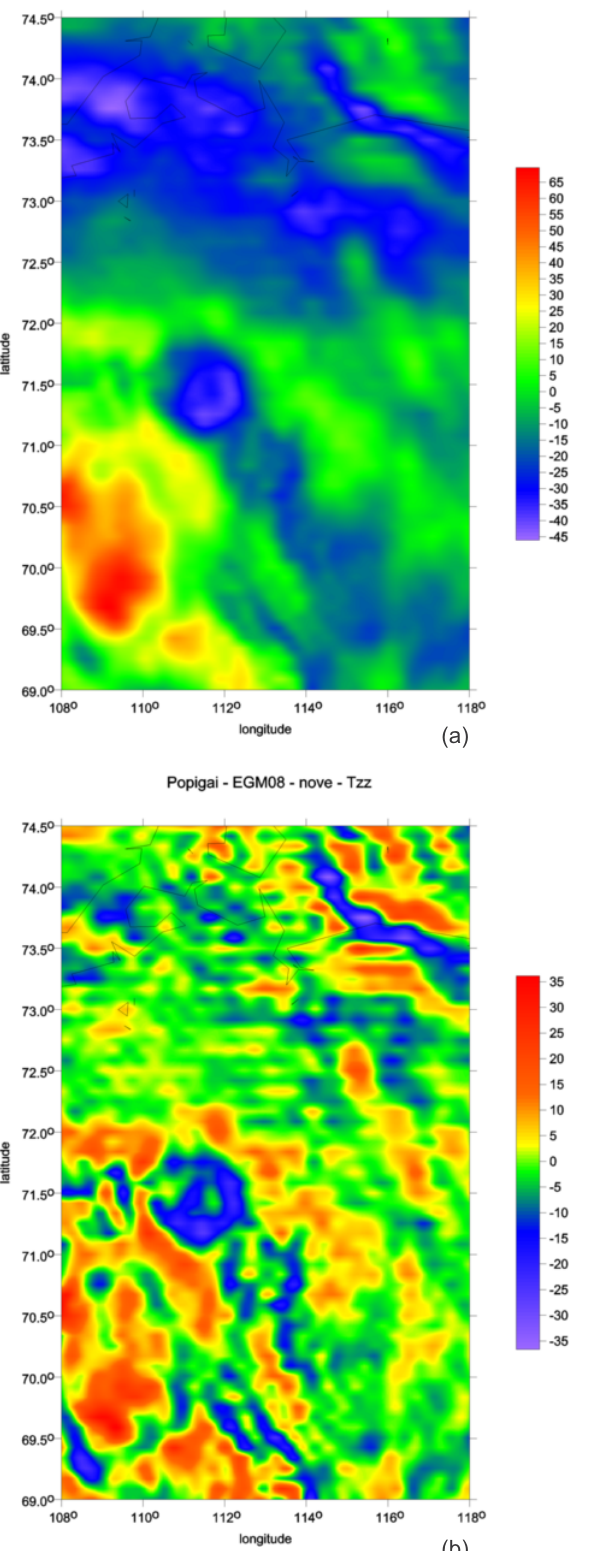
and (c) vd the for impact crater Popigai, Siberia (diameter of the main crater on the NW side is about 100 km). Re- Figure 7. (a) D g , (b) T z produced partly (panels (a) and (b)) from Kloko č ník et al.